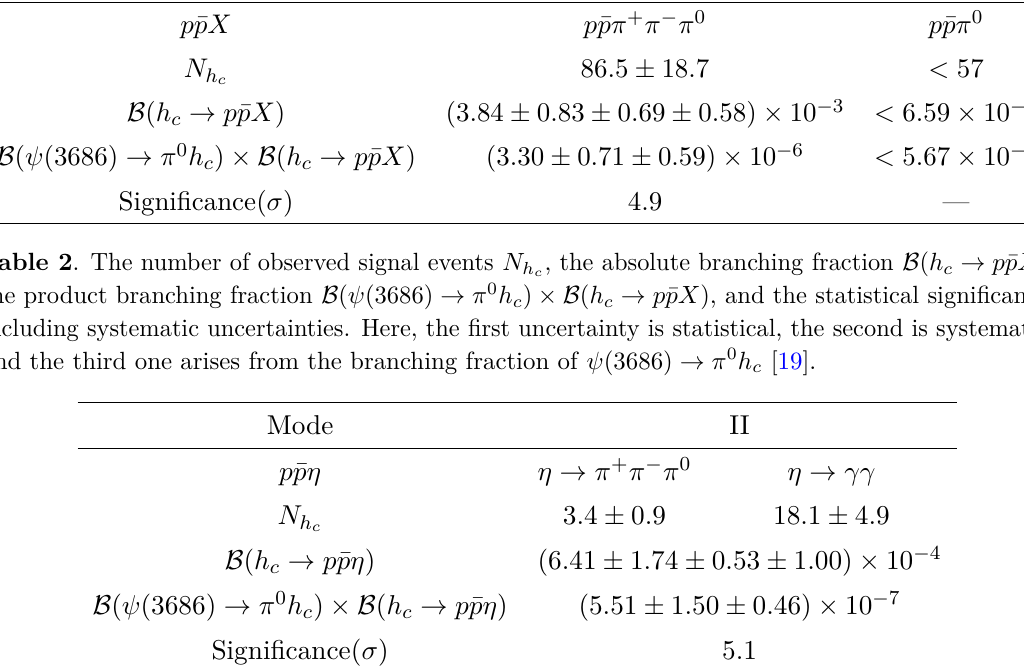
Table 3 . The number of observed signal events N h the product branching fraction B ( ψ (3686) → π 0 h including systematic